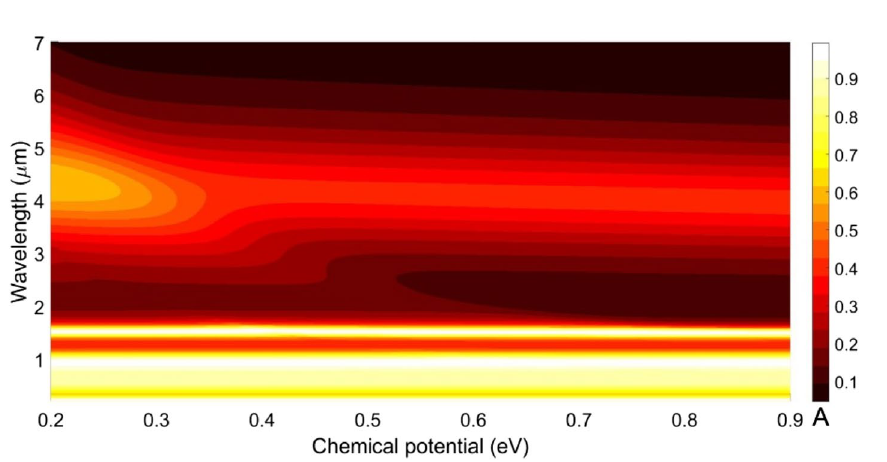
Figure 10. Effect on the absorption spectra due to altering chemical potential of graphene, while the other parametric and operational conditions are used as in Fig. 9.